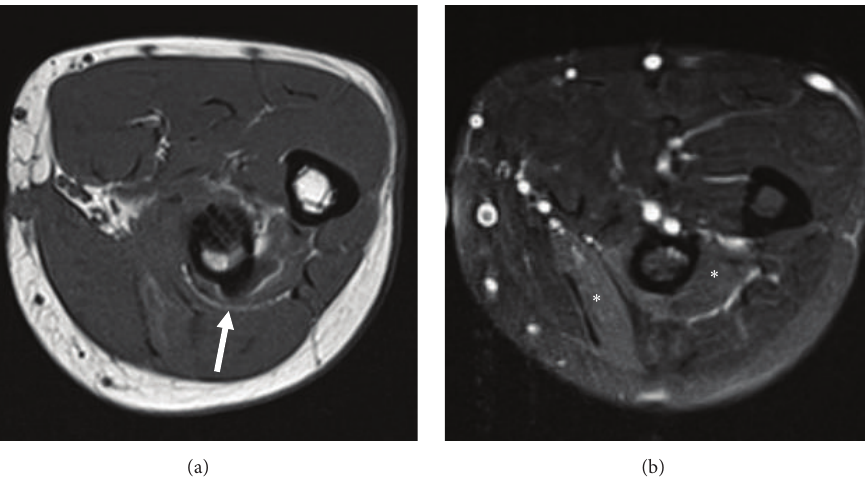
Figure 2: Axial T1 (a) and T2 (b) fat saturated images from patient 2. In (a), surgical artifact along the posterolateral margin of the radius can be seen approaching but not definitively compressing or obscuring the deep radial nerve or proximal PIN (white arrow). Neurogenic edema is noted in the ECRB and supinator muscles in (b)